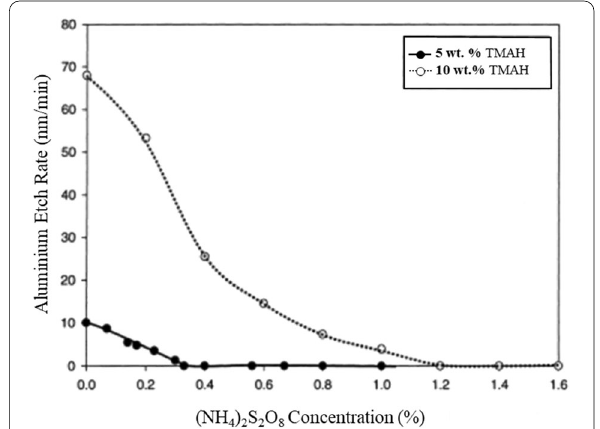
Fig. 24 Etch rate of aluminium as a function of (NH 4 ) 2 S 2 O 8 concentration at 85 °C. The amount of dissolved silicon in 5 and 10 wt % TMAH are 1.6 and 3.2 wt%, respectively [106], © 2001, Elsevier